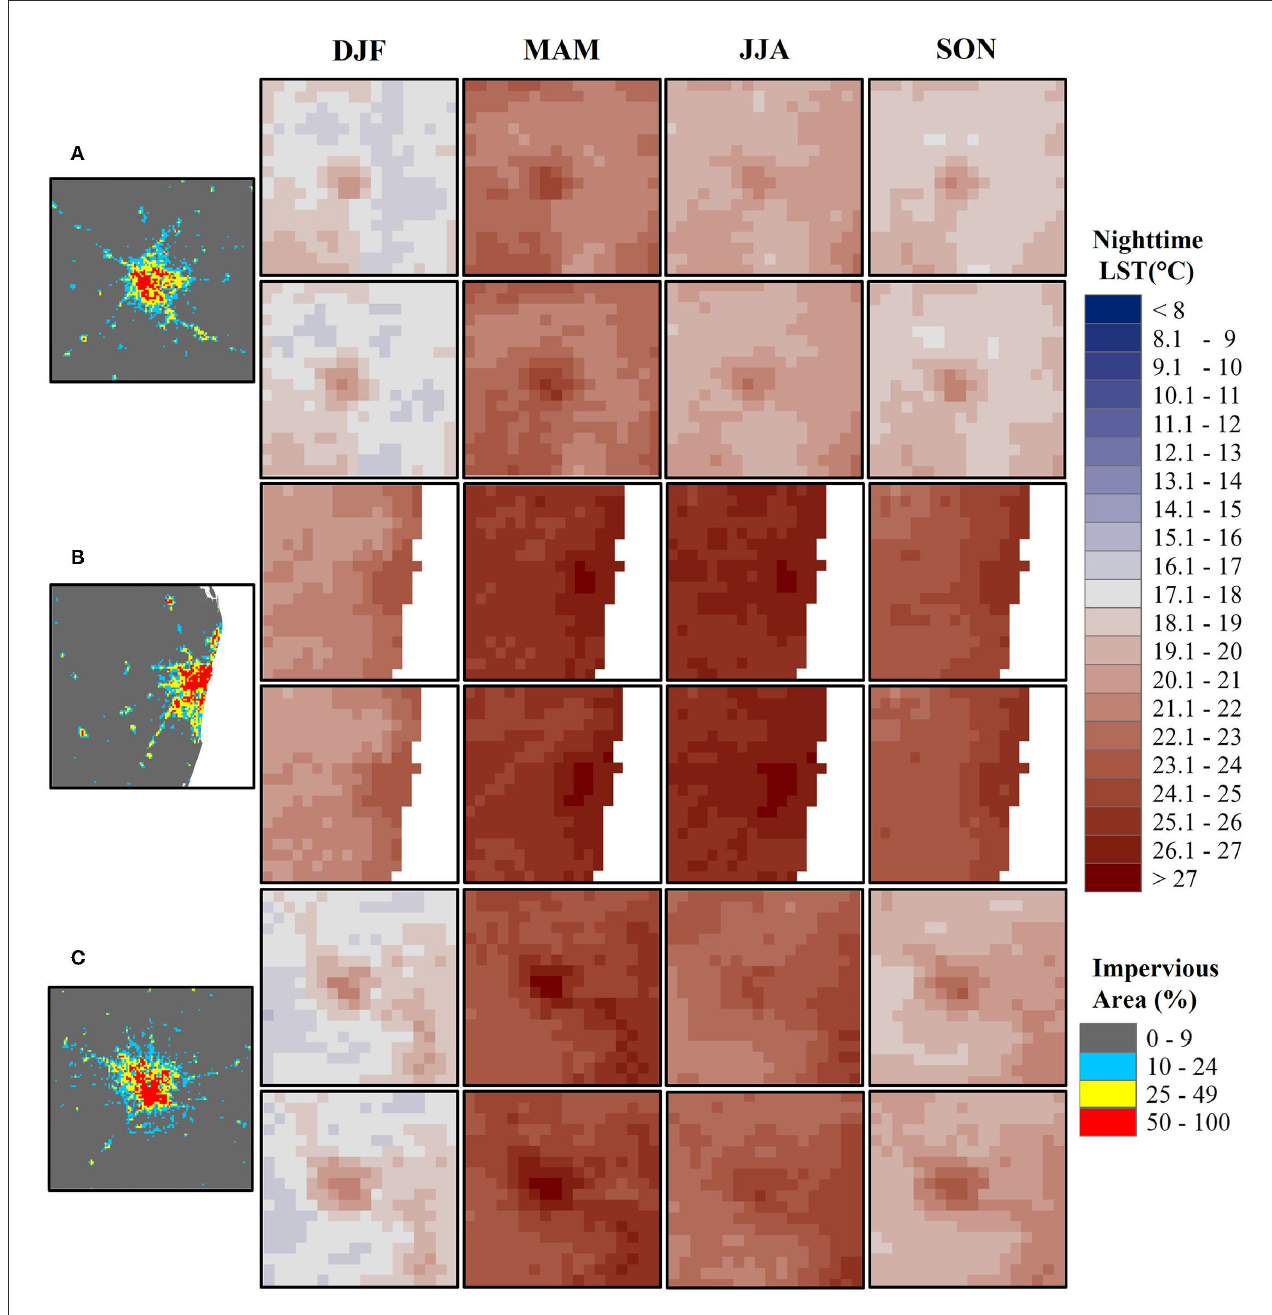
FIGURE3 Same as Figure 2, but for cities (A) Bangalore, (B) Chennai, and (C) Hyderabad.